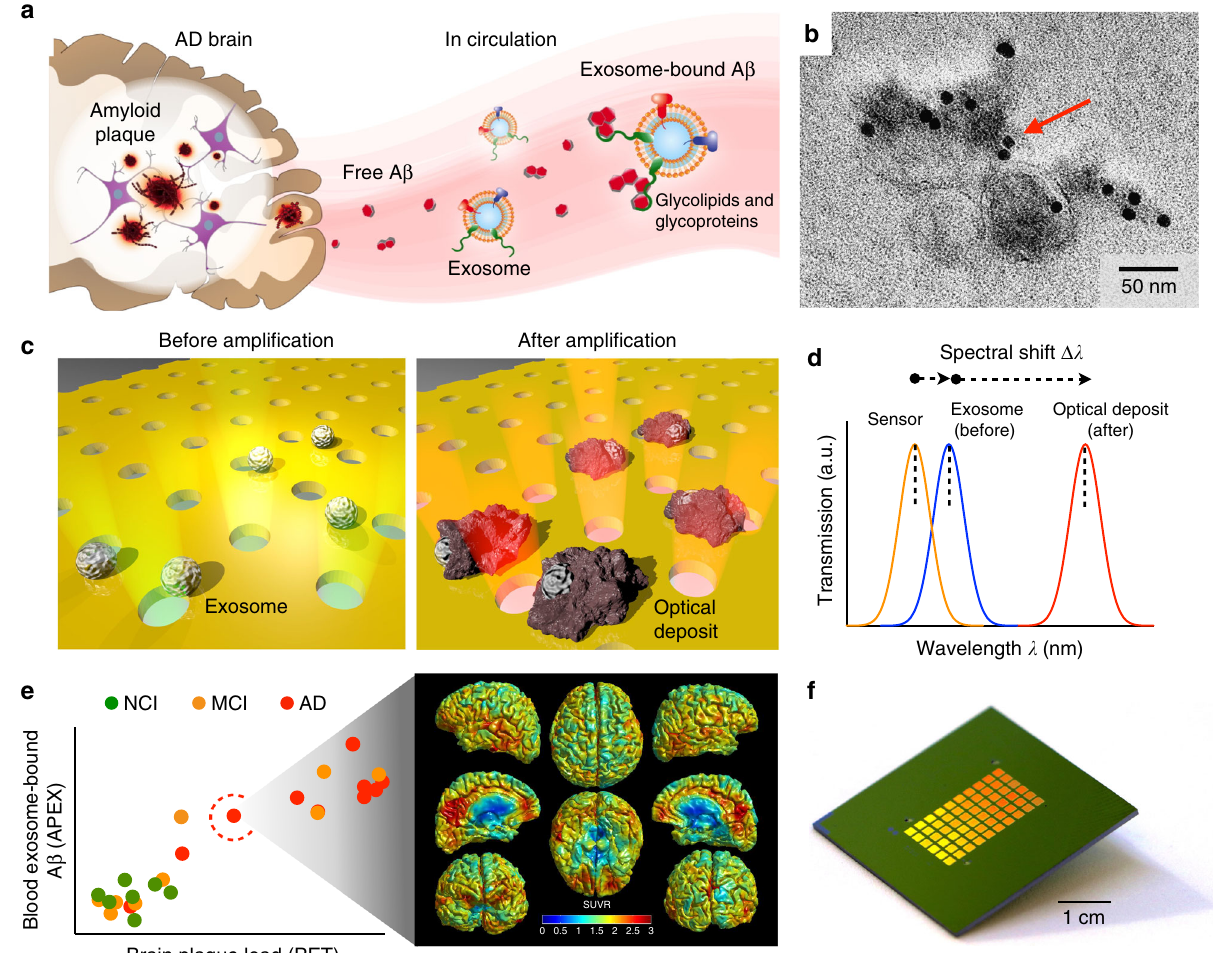
Fig. 1 APEX platform for analysis of circulating exosome-bound A β . a Exosomes associate with A β proteins. A β proteins, the main component of amyloid plaques found in AD brain pathology, are released into the extracellular space. Exosomes are nanoscale extracellular membrane vesicles actively secreted by mammalian cells. Through their surface glycoproteins and glycolipids, exosomes can associate with the released A β proteins. b Transmission electron micrograph of exosome-bound A β . Exosomes derived from neuronal cells (SH-SY5Y) were treated with A β 42 aggregates, and labeled with gold nanoparticles (10 nm) via a A β 42-speci fi c antibody. The nanoparticles appear as block dots (indicated by the red arrow). c APEX assay schematics. To enable sensitive pro fi ling at the nanoscale, exosomes are fi rst immuno-captured onto a plasmonic nanosensor (before ampli fi cation). Through an in situ enzymatic ampli fi cation, insoluble optical deposits are locally formed on the sensor-bound exosomes (after ampli fi cation). This deposition is spatially de fi ned for molecular co-localization analysis, and changes the refractive index for SPR signal enhancement. To complement the enzymatic ampli fi cation, the nanosensor is back illuminated (away from the enzyme activity) to achieve analytical stability. The deposition causes a resultant red shift in the transmitted light through the nanosensor. d A representative schematic of changes in the transmission spectra with APEX ampli fi cation. Speci fi c exosome binding (before) and subsequent ampli fi cation pro fi ling (after) were monitored as transmission spectral shifts ( Δλ ) by the APEX platform. a.u., arbitrary unit. e Exosome-bound A β was measured using the APEX platform, in blood samples of patients with Alzheimer ’ s disease (AD), mild cognitive impairment (MCI), and controls with no cognitive impairment (NCI). The blood measurements were correlated to corresponding PET imaging of brain amyloid plaque deposition. f A photograph of the APEX microarray. Each sensor chip contains 6 × 10 sensing elements, made up of uniformly fabricated plasmonic lattice, for multiplexed measurements. See Supplementary Fig. 3 – 6 for sensor fabrication, characterization and design optimization,